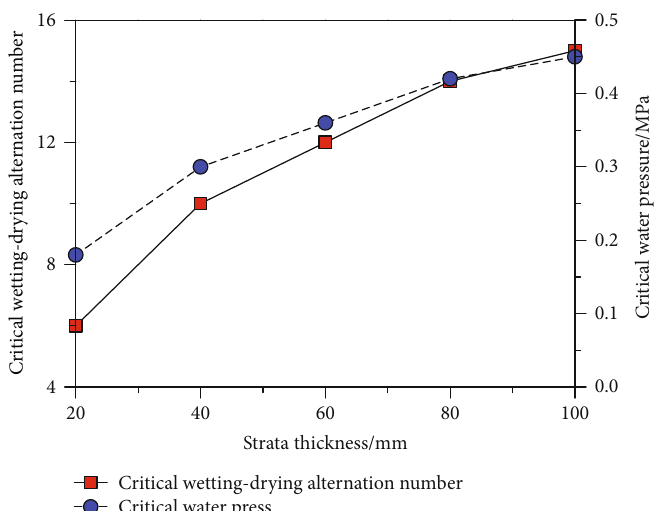
Figure 10: Variations in critical wetting-drying alternation number and critical water pressure with di ff erent stratum